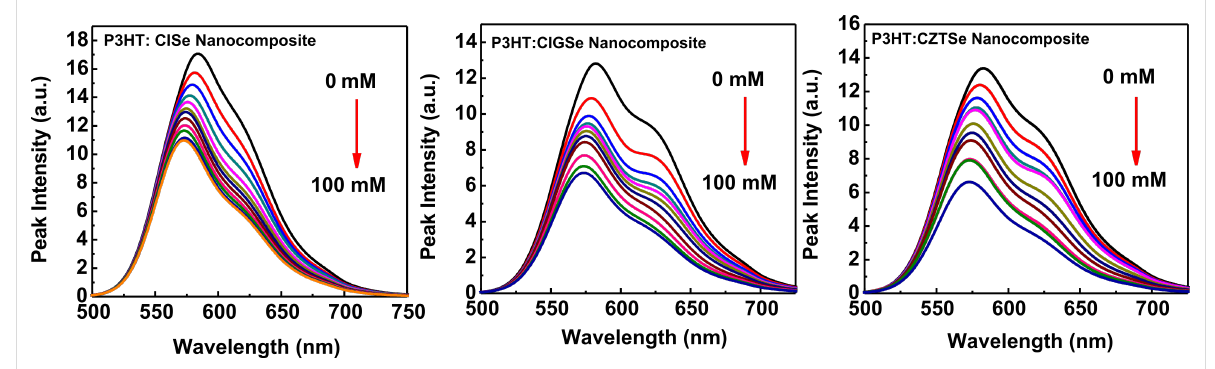
Figure 5: Emission intensity profiles of polymer:chalcopyrite nanocomposites dispersed in toluene ( λ max = 580 nm and concentration of chalcopyrites varying from 0–100 mM), (a) P3HT:CISe; (b) P3HT:CIGSe; and (c) P3HT:CZTSe.